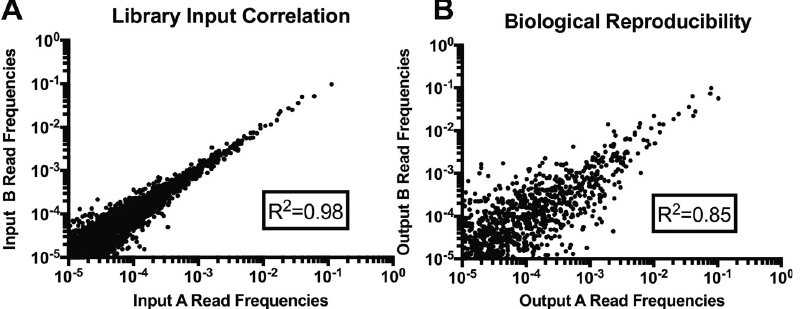
Fig 1. Correlation between replicates of the larval tick survival Tn-seq experiment. (A) Correlation between the mutant compositions of the two replicate cultures of the input Tn library. (B) Correlation between the mutant compositions of the two replicate cultures of the Tn mutants recovered from the fed larvae (output library). Each data point represents the frequency of an individual Tn mutant in relation to the total input or output respectively. Each axis represents a different biological